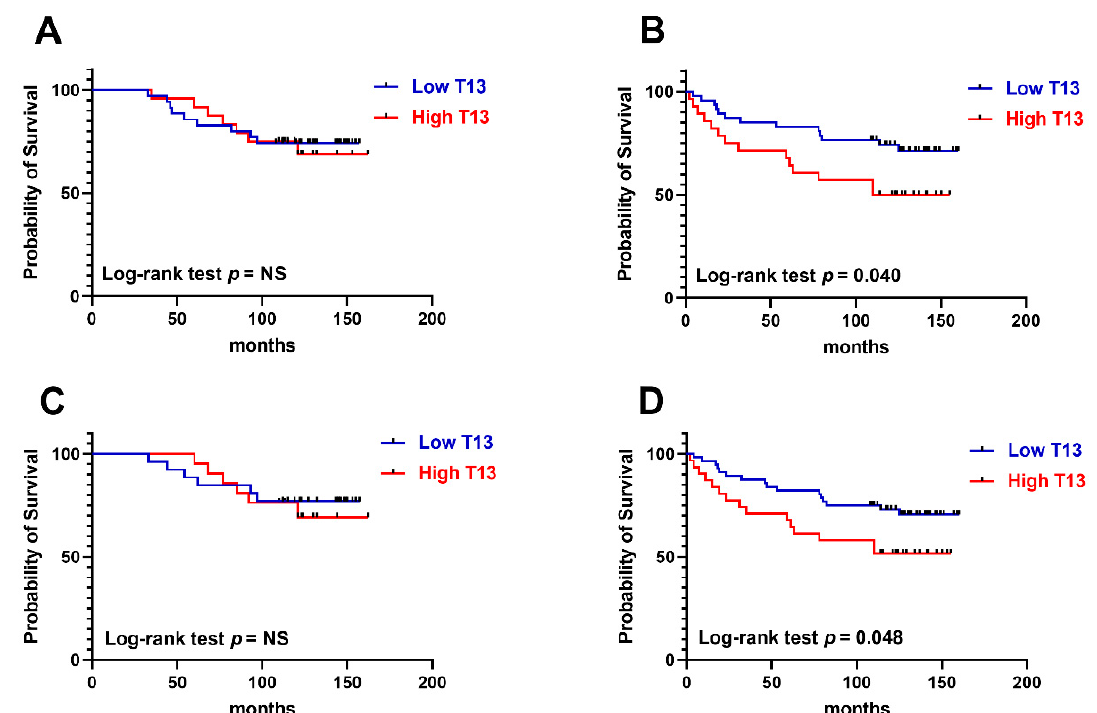
Figure 6. Kaplan–Meier overall survival rates related to GalNAc-T13 expression. ( A ) Early stage tumors (stages I and IIA) ( n = 59). ( B ) Advanced stage tumors (stages IIB and III) ( n = 75). ( C ) Patients without lymph node involvement ( n = 47). ( D ) Patients with metastatic lymph nodes ( n =